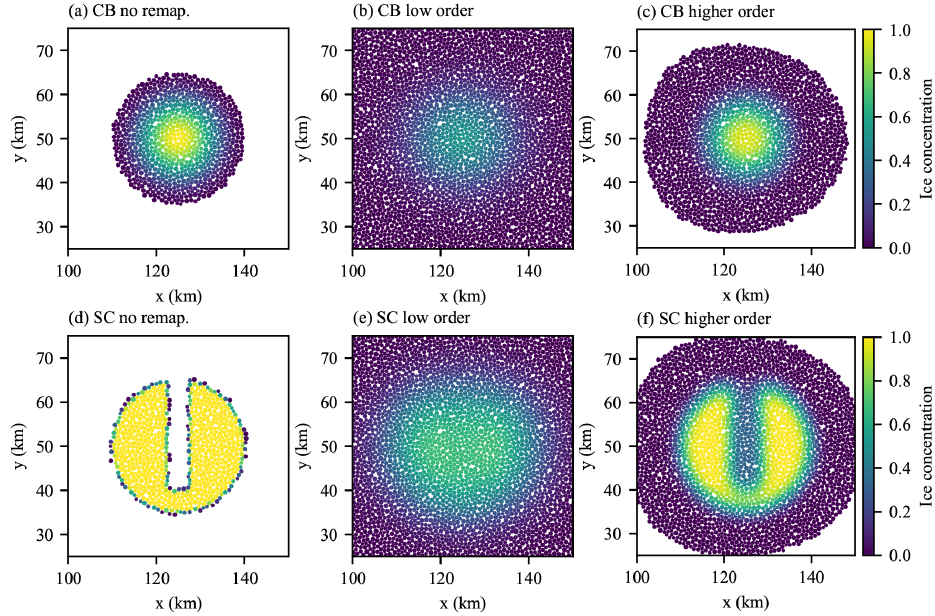
Figure 5. Final ice concentration (fraction of elements covered in sea ice) for the two-dimensional remapping test case with an initial cosine bell (CB: a–c ) and slotted cylinder (SC: d–f ) particle distribution. (a, d) No remapping, (b, e) low-order remapping, and (c, f) higher-order remapping.